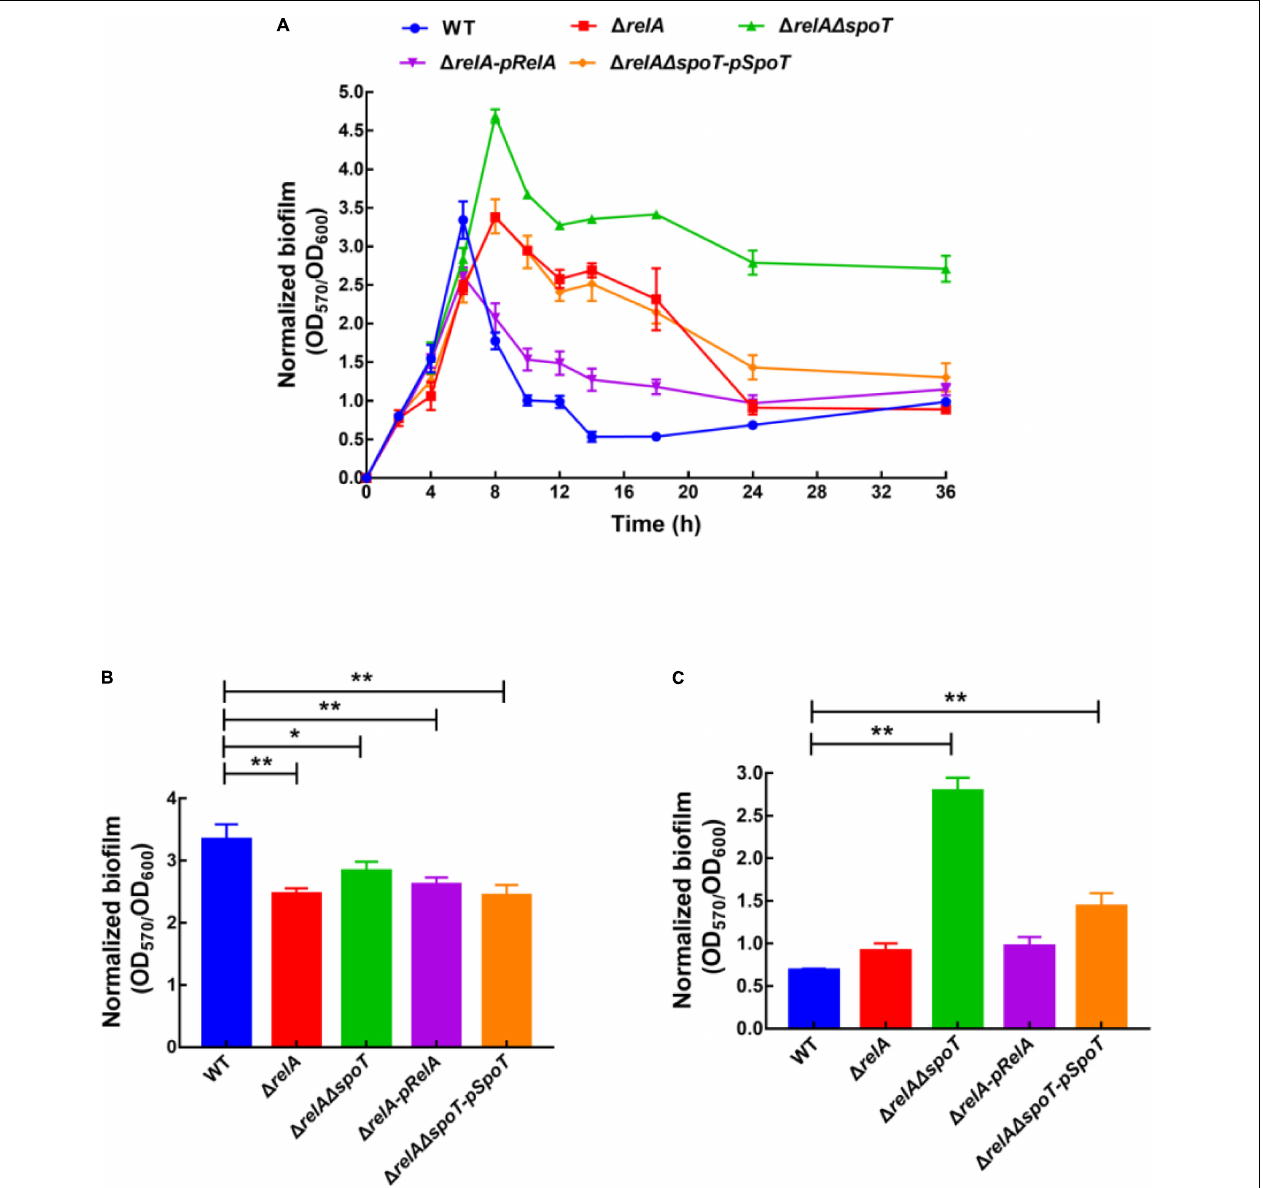
FIGURE 1 | Normalized biofilm formation (total amount of biofilm/growth) of WT, (cid:49) relA , (cid:49) relA (cid:49) spoT , (cid:49) relA-pRelA , and (cid:49) relA (cid:49) spoT-pSpoT in 96-well polystyrene microtiter plates at different cell densities (A) . The normalized biofilm differences between WT and (cid:49) relA , (cid:49) relA (cid:49) spoT , (cid:49) relA-pRelA , and (cid:49) relA (cid:49) spoT-pSpoT were shown at 6 (B) and 24 h (C) , respectively. Three separate experiments were performed with biological triplicates each, and results were presented as mean ± SD ( n = 3). * indicates p ≤ 0.05, and ** indicates p ≤